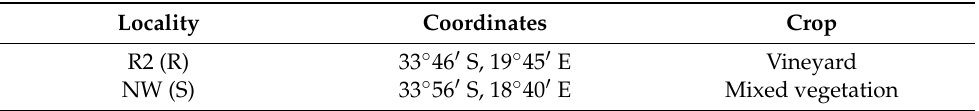
Table 1. Localities where resistant (R) and susceptible (S) plantago ( Plantago lanceolata L.) biotypes were collected.